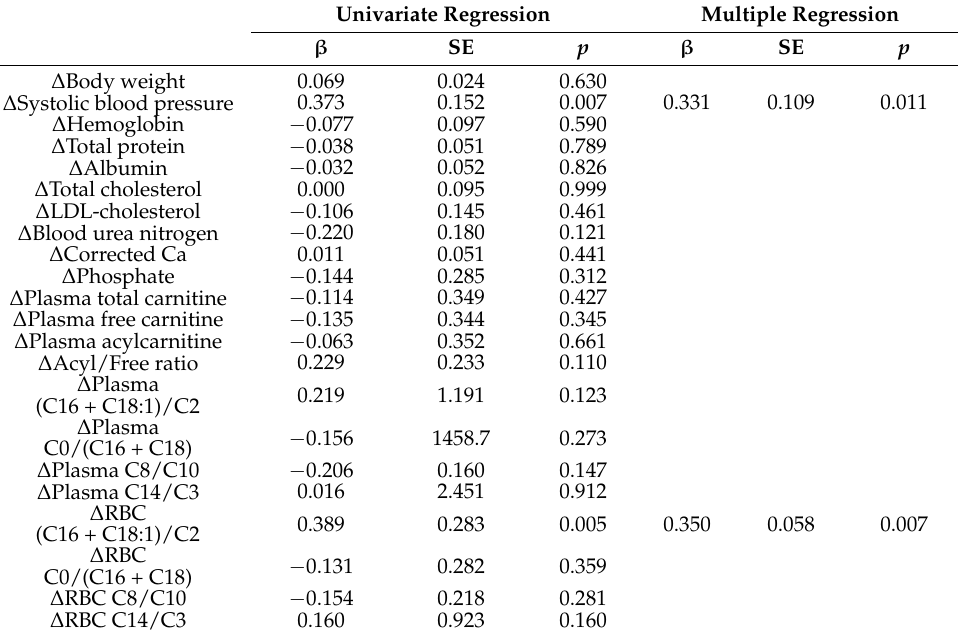
Table 4. Univariate and multiple regression analyses for the covariates of changes in